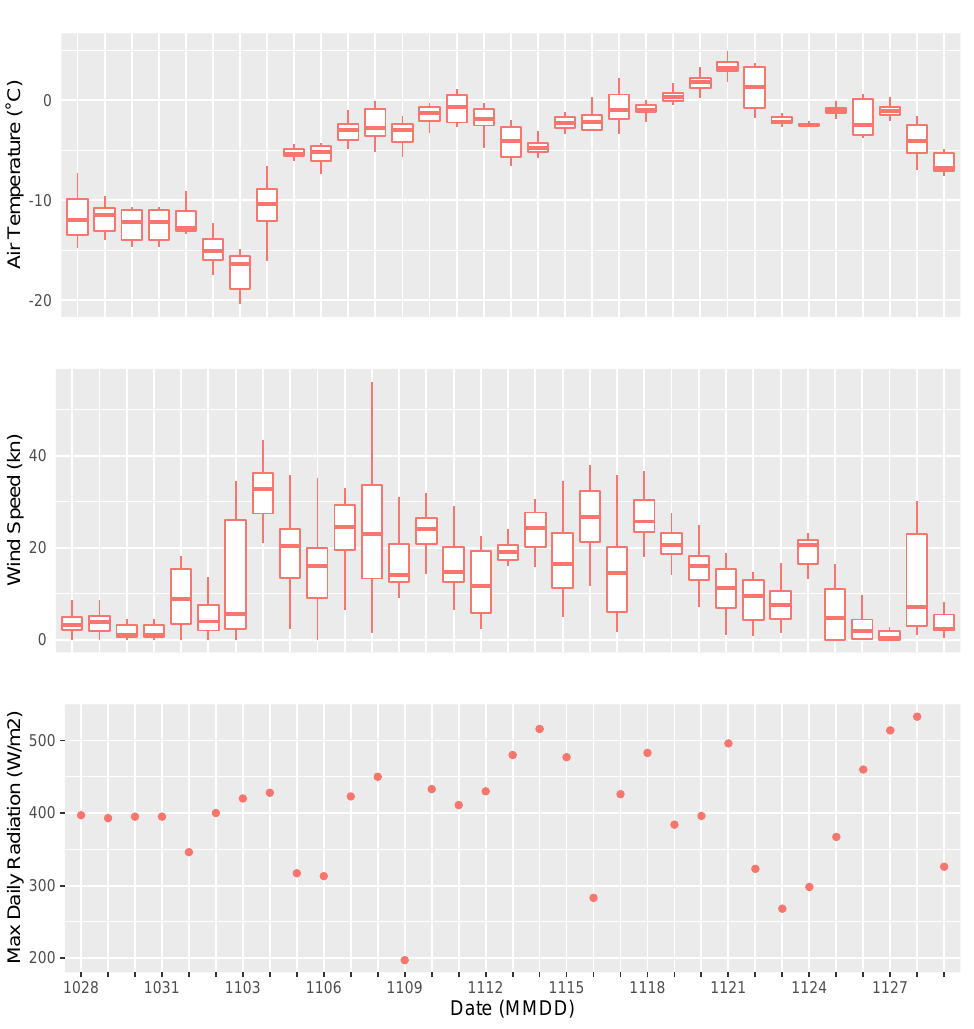
Figure 2. Meteorological data, November 1997, ENEIDE Station. Note the different trend of air temperature between week I (14–21 November) and week II (22–29 November). Temperature and salinity measured during November at FRIDA point (Figure 1; 74°41.725 S; 164°11.633 E), which is close to the PIPEX field site, are shown in the T-S dia- gram of Figure 3a. Two main oceanographic features are highlighted: (1) the presence of water masses with low salinity, due to ice-melting, entering the site at ≈ 25 m depth, and (2) the process of mixing on the shelf leading to the formation of Antarctic Shelf Water (T = −1 .9 °C, S = 34.75). Focusing on the vertical profiles in terms of potential density anomaly, at the beginning of the month, the water column exhibited a vertically homogenous tem- perature close to the freezing point and density anomaly equal to 28.01 kg m −3 . After that, the density in the upper 10 m thick layer decreased below 28 kg m −3 due to the joint effect of weak warming and dilution, which produced a mixed layer down to about 40 m depth. Surface ice-melting These processes proceeded very slowly to form a small vertical density gradient. Towards the end of the period, the surface warming became stronger (+0.2 °C), and the pycnocline, though not well defined, progressively deepened, possibly facilitating the ingression of lateral fresher tongues. Density in the upper 10 m thick layer further decreased to 27.94 kg m −3 , fostered by the pack-ice melting that induced salinity minima of ≈ 34.7 at 5 to 10 m depth and generated a mixing layer from 10 to 30 m depth. Figure 3. Oceanographical data, FRIDA Station. ( a ) T-S diagram. ( b ) Vertical profiles of fluorescence (dates: 7, 13, 17, 21, 26, and 28 November). A uniform background fluorescence of about 0.1 ug l −1 was present throughout the water column when the temperature was close to the freezing point ( −1 .86 °C) during the first week of the campaign (Figure 3b). An increase in fluorescence was observed during the second week of sampling, when the surface temperature increased. At the very end of November, warmer temperatures led to a strong increase in biological activity, as high- lighted by the fluorescence profiles that increased to 10-to-20 times the background values in the mixed layer. During the first half of November, temperature varied little throughout the water column (Figure 4, upper left panel); averages remained close to the freezing point ( −1 .86 °C), with only a light signal of surface warming. Salinity exhibited strong fluctuations in the uppermost 20 m due to ongoing ice melting (Figure 4, upper right panel); averages ranged around 34.6 – 34.7, and episodes of surface intrusion of fresher water, possibly from lateral advection, were observed. During the second half of November, surface warming increased, and the expected water mixing on the shelf dominated, with noticeable effects down to 50 m depth (Figure 4, upper left panel); average temperatures within the layers sampled by MicroNESS were ≈−1 .5 °C, with salinity ≈ 34.8 (Figure 4, upper right panel). In the later period, no evident effects of fresher inputs were observed. The output from the ROMS modelling is shown in the lower panels on the same fig- ure (Figure 4, lower panels, T and S); to facilitate comparison, the values were binned into the same vertical depth strata used for the measured profiles. As expected, the variability in model output appears larger than (but consistent with) measured variability, since the modelled data integrated both the climatic fluctuations of 15 years and the spatial condi- tions of a 5 × 5 km 2 cell. The variability was more pronounced in the second half of No- vember for both T and S. In particular, within the 20 m thick uppermost layer and below 150 m depth, the modelled thermal structure reflected the trend shown in the PIPEX field data, while the intermediate layer (50 – 150 m) exhibited more dynamic behaviour. For sa- linity, during the first half of November, the observed ranges were well represented within the modelled variability, whereas in the second part of the month the uppermost layers appeared to be more dynamic and dominated by ice-related processes, leading to an excess of freshening.